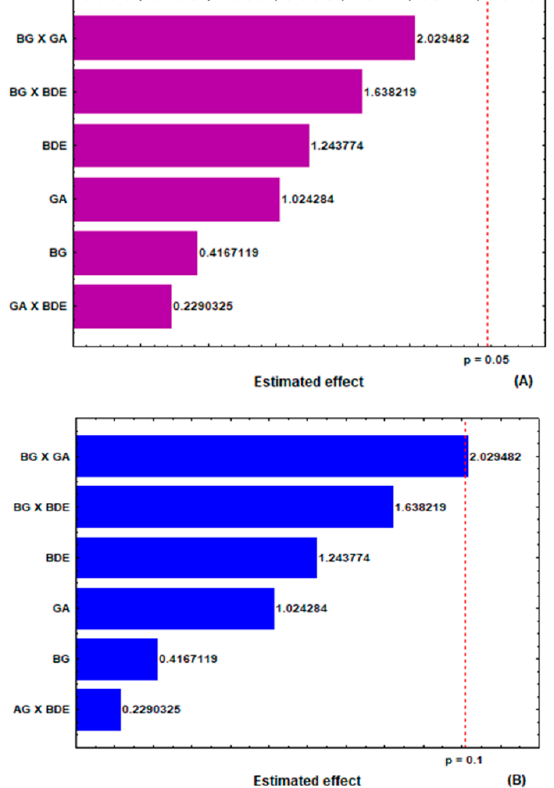
Figure 4. Estimated effects of the concentrations of β -glucan (BG), gum arabic (GA) and B. dracunculifolia extract (BDE) on the microparticles zeta potential at the 95% ( A ) and 90% ( B ) confidence levels.